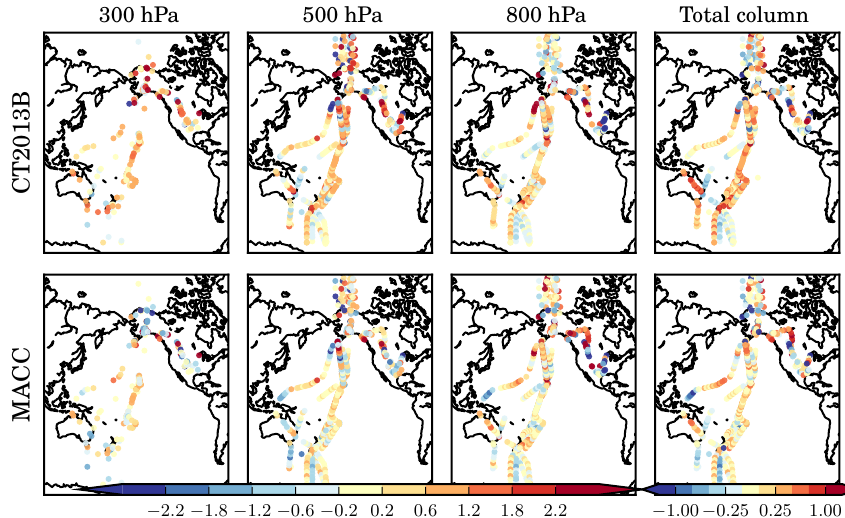
Figure 2. Top row, from left to right: CT2013B–HIPPO differences at 300, 500, 800hPa, and column-averaged mixing ratio of CO 2 . Bottom row: as for the top row but for the MACC model. Note the change in color scale between layer and total column differences. All HIPPO campaigns are